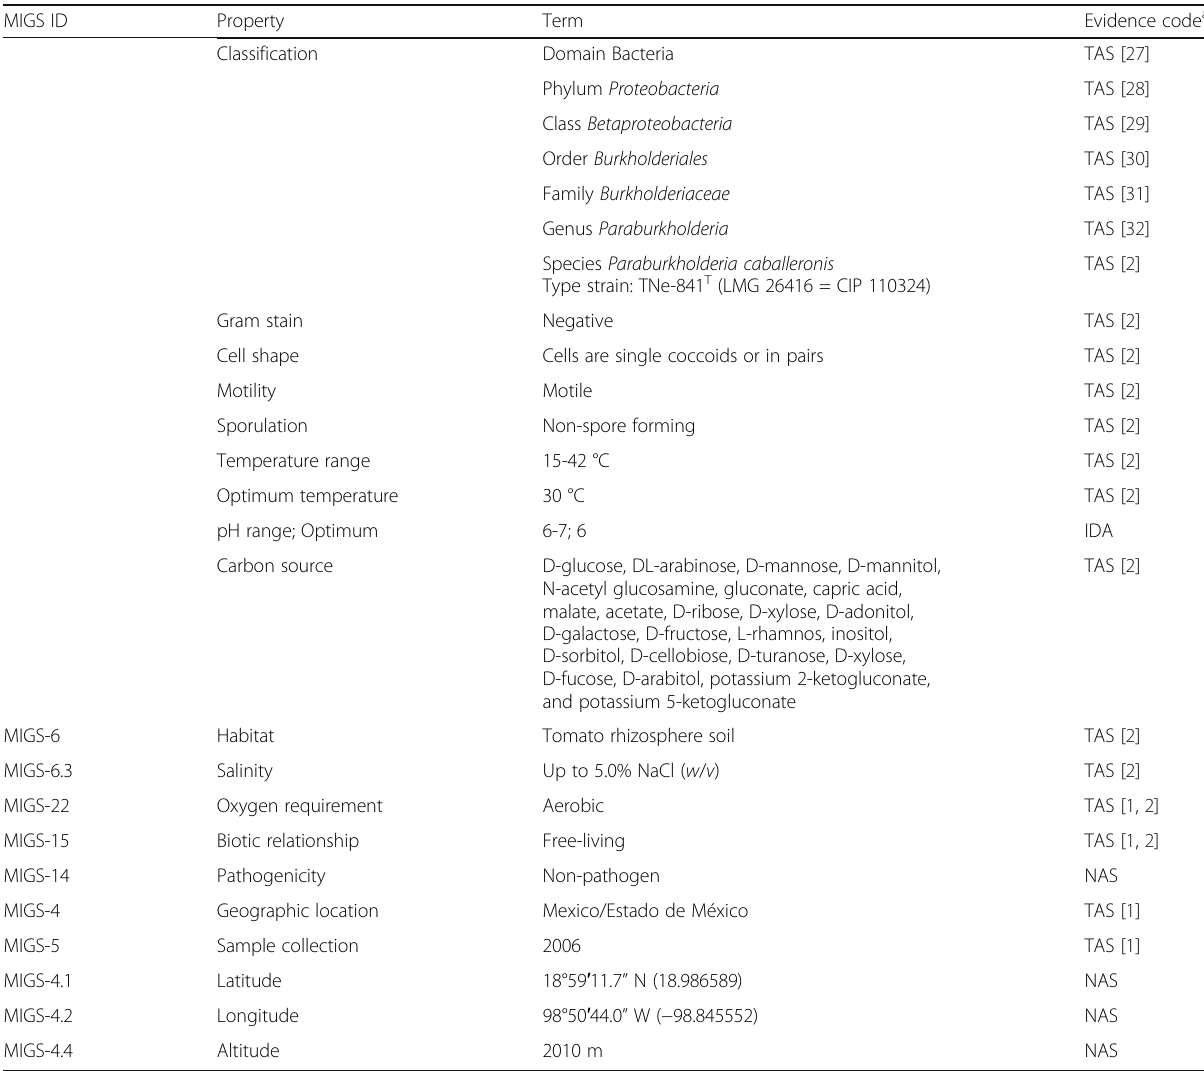
Table 1 Classification and general features of Paraburkholderia caballeronis strain TNe-841 T